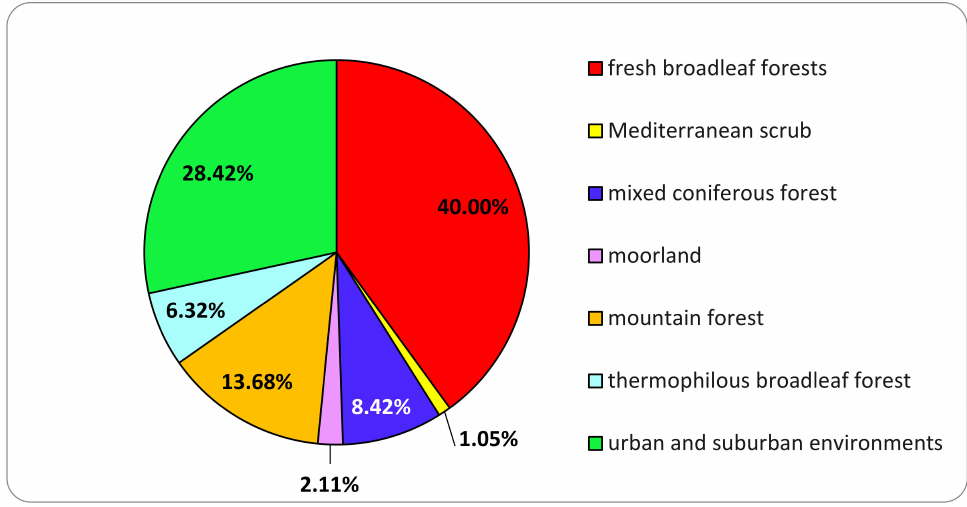
Figure 2. Distribution of the isolates among the explored habitats where the basidiomata originated. In total, 26 genera of trees on which the fungal species were growing could be identified (Figure 3). In particular, the majority of the collected basidiomata were growing on Quercus spp. (12%).